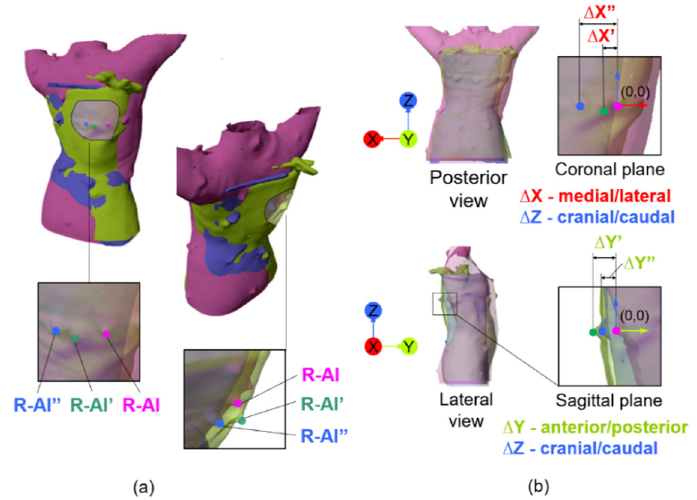
Figure 3. Anatomical landmark position (ALP) analysis. ( a ) The isometric views of the three scans aligned showing the location of marker right angulus inferior scapulae (R-AI) for the patient’s scan (R-AI), pre-rectification mould scan (R-AI’), and post-rectification mould scan (R-AI”). ( b ) Posterior (top) and lateral (bottom) view of the three scans aligned and measure of ALP differences in the coronal and sagittal plane. The X -axis represents the medial/lateral direction; Y -axis is the anterior/posterior direction and Z -axis the cranial/caudal direction.